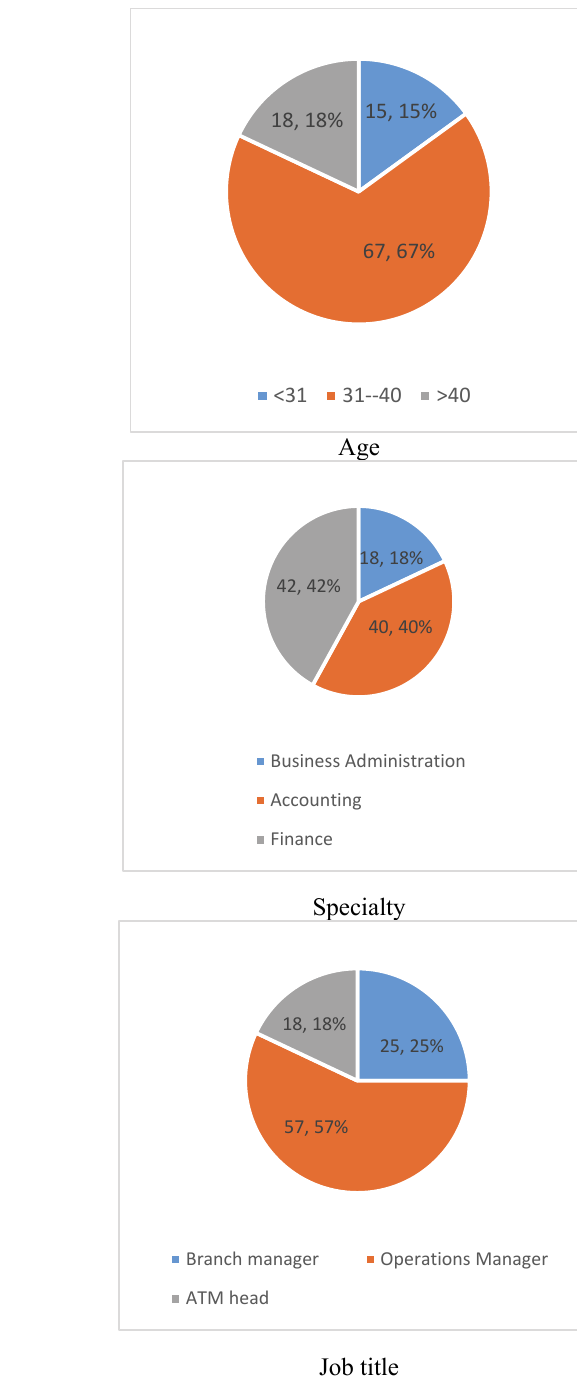
Fig. 1. Characteristics of the study